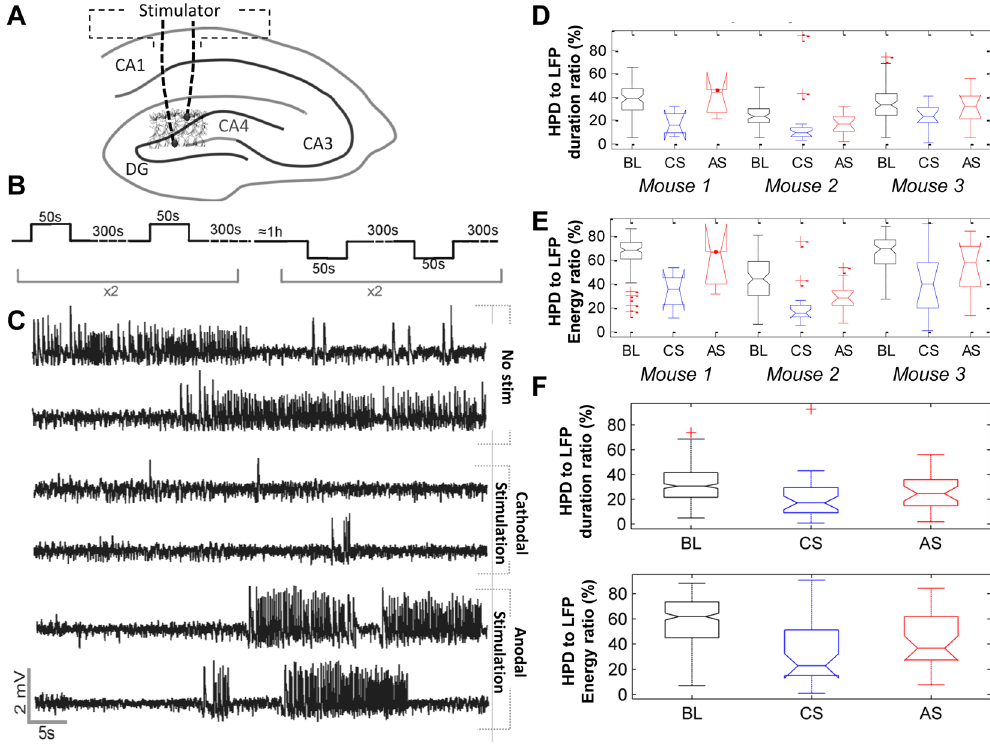
Figure 2. Differential effects of anodal and cathodal stimulation on HPD characteristics. ( A ) Illustration of the stimulation electrode tips position across the GC layer in the DG. ( B ) LDCS protocol followed to identify which stimulation polarity was efficient in decreasing tissue hyperexcitability. ( C ) Time series of recorded LFP during epochs of 1) no stimulation, 2) cathodal stimulation (CS), 3) anodal stimulation (AS). The significant reduction of HPD duration and occurrence during CS is noticeable. ( D ) Boxplot of the HPD to total recording duration ratio for the three tested animals, without stimulation, and during CS/AS. ( E ) same as ( D ) for the HPD to LFP energy ratio. ( F ) Upper panel : Pooled results on the three mice regarding the HPD to LFP duration ratio. Lower panel : same as ( F ) for the HPD to LFP energy ratio. Red crosses are data points outside the 1.5 * IQR (interquartile range) represented by the whiskers, as provided by Matlab (The Mathworks, USA). For each box, the central line is the median, while the lower/upper edges are the 25 th and 75 th data percentiles,